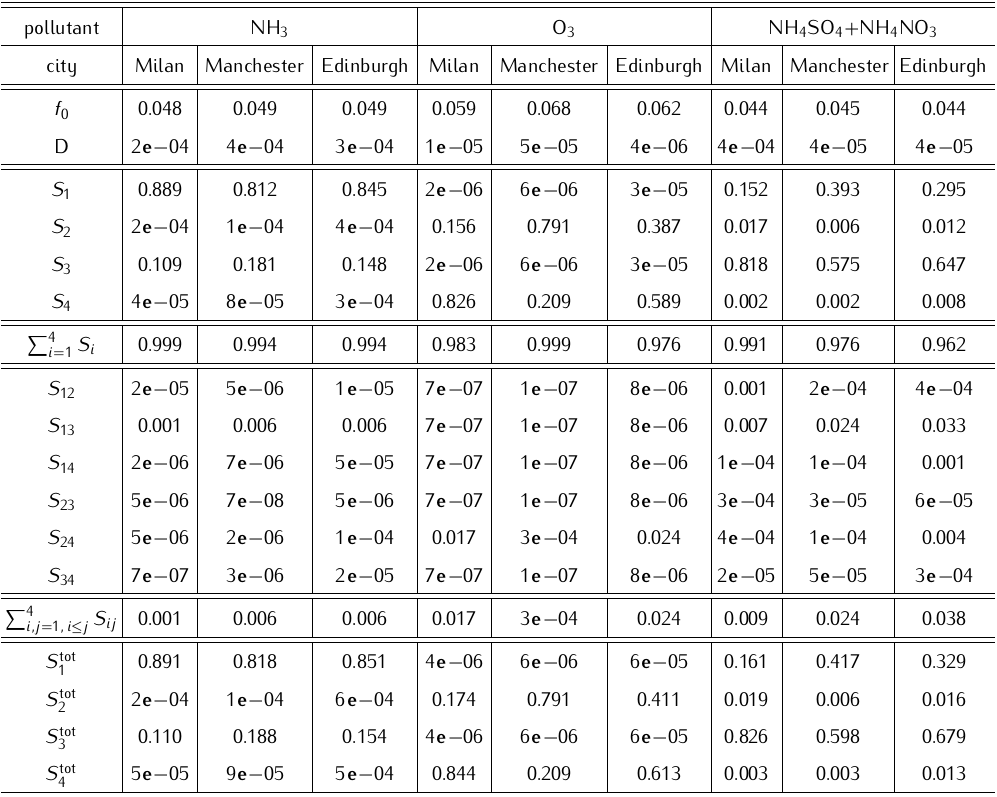
Table 3. First-order, higher-order and total sensitivity indices of input